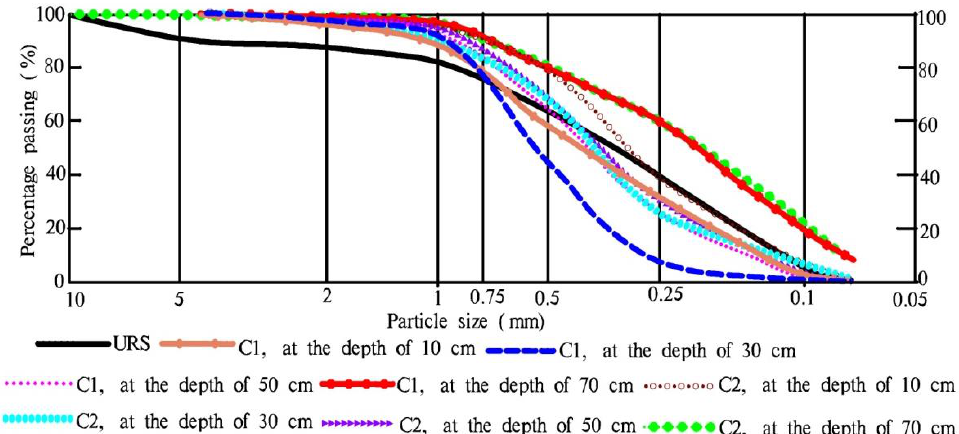
Figure 13. Accumulative curve of particle gradation of soil with overlaying soil thickness of 70 cm (C1 and C2).